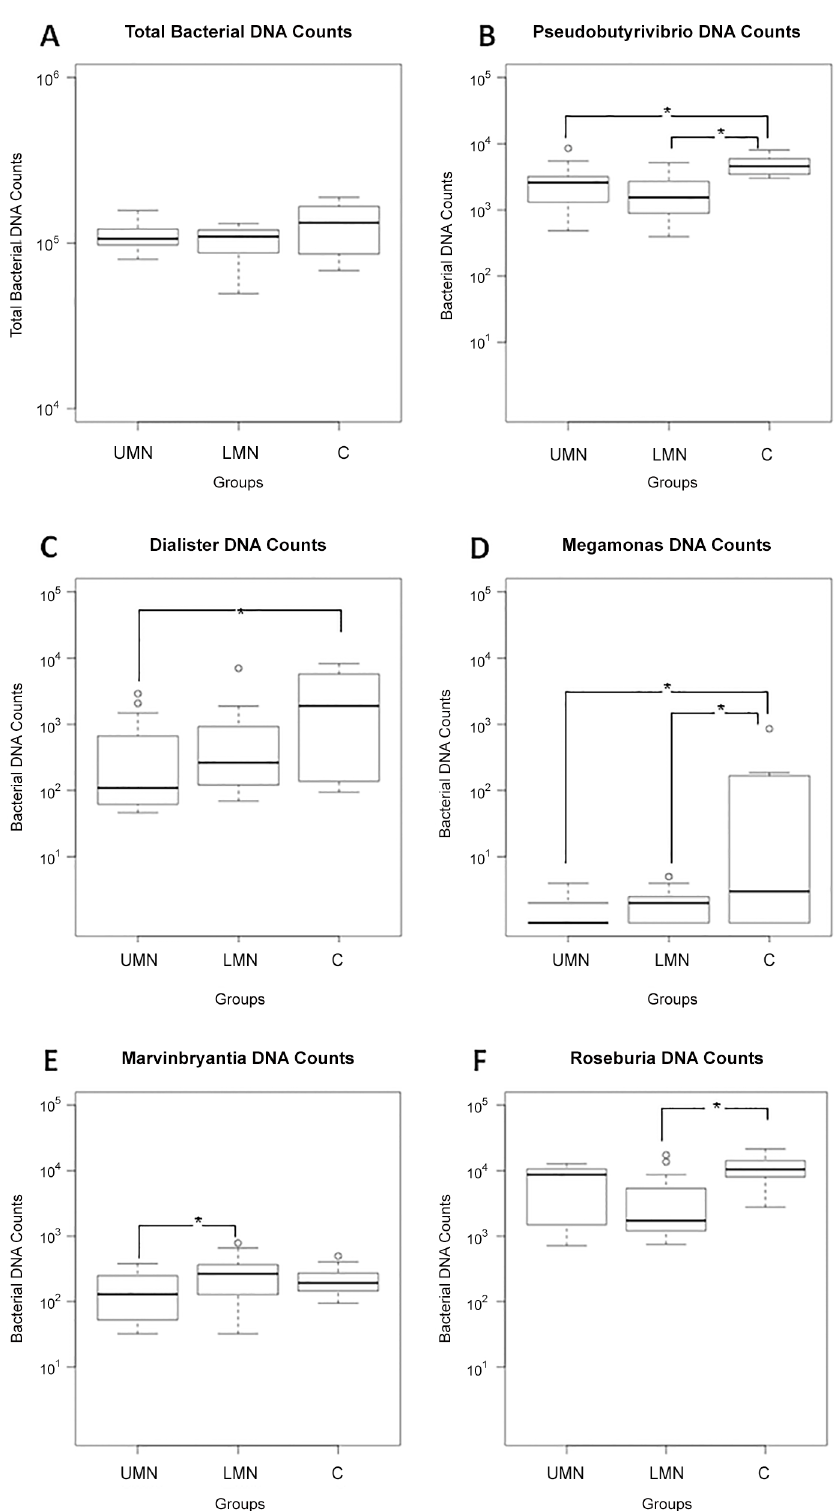
Fig 2. Gut microbiome composition profiles that differed between UMN group (n = 15), LMN group (n = 15), and control group (n = 10). The values represent bacterial DNA counts in gut microbiome. (A) Total bacterial counts; (B) Pseudobutyrivibrio; (C) Dialister; (D) Megamonas; (E) Marvinbryantia; (F) Roseburia.